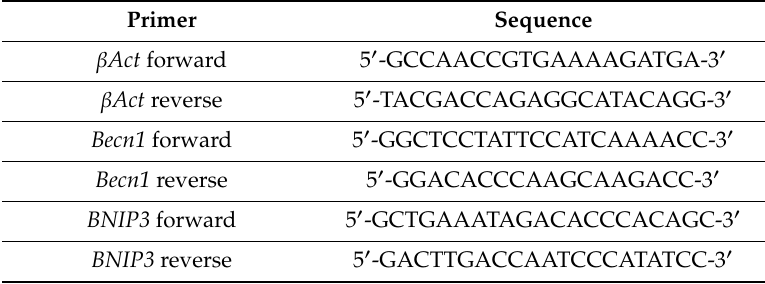
Table 2. Primers used for